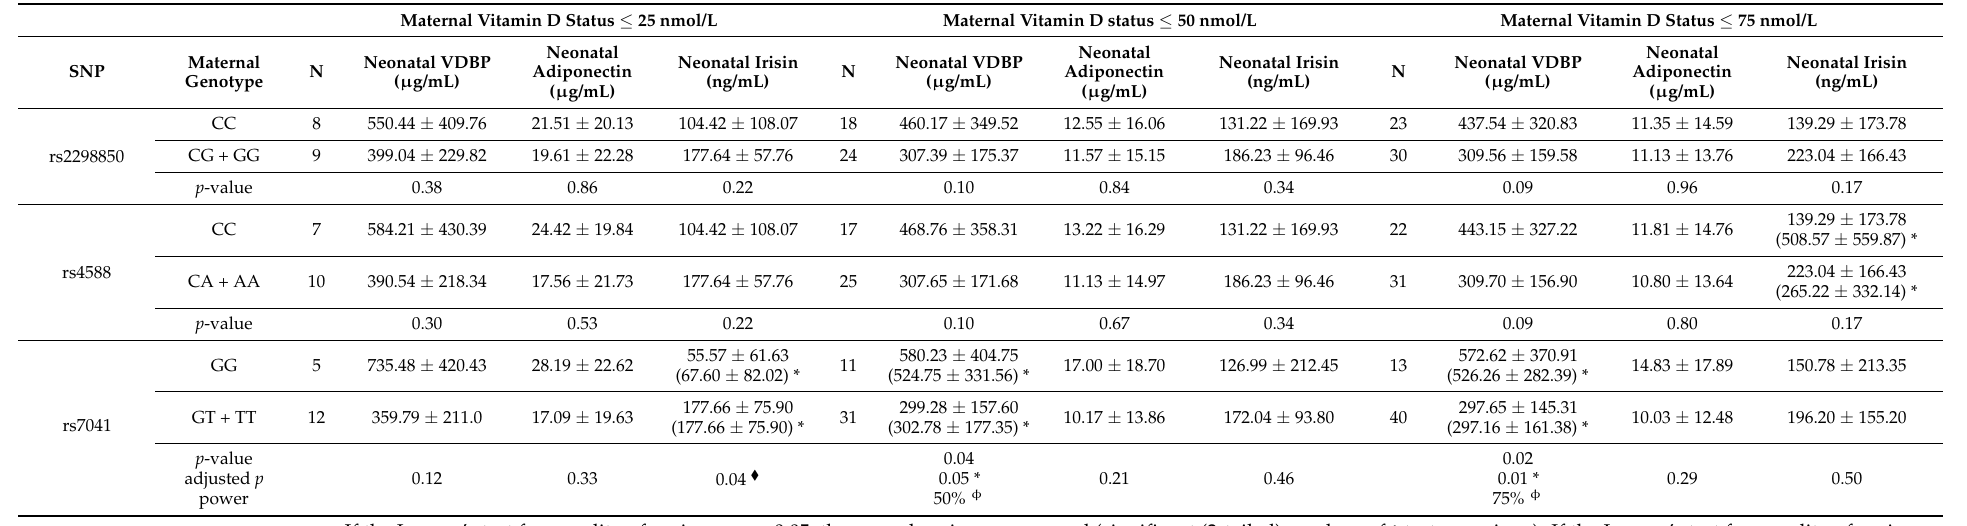
Table 5. Neonatal serum biomarkers according to maternal vitamin D status and maternal VDBP